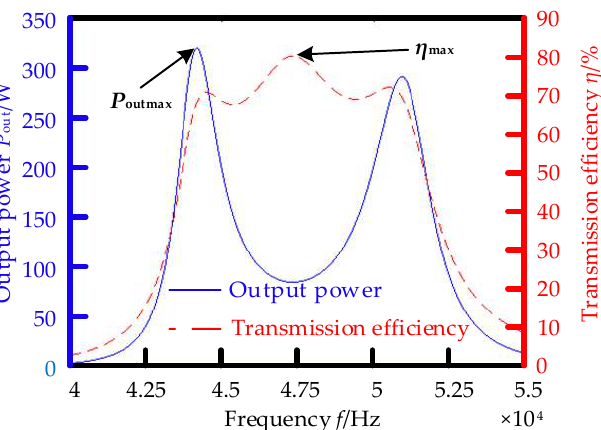
Figure 2. Relation curves of system frequency with transmission efficiency and output power when frequency splitting occurs.